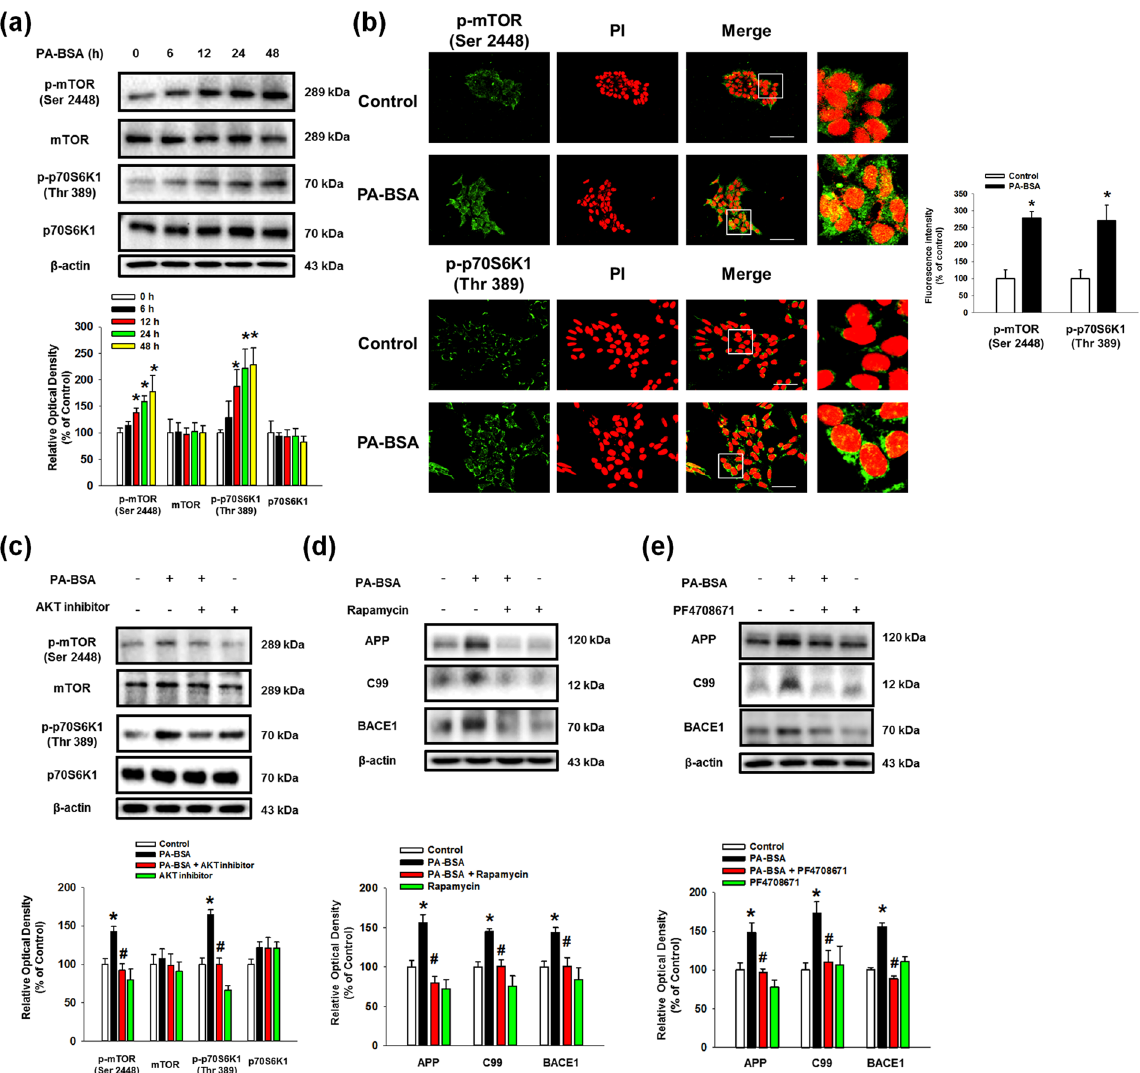
Figure 5. Role of mTOR activated by PA-BSA in APP and BACE1 expressions. ( a ) SK-N-MC cells were incubated with PA-BSA (50 μ M) for 0–48 h. Cells were blotted with p-mTOR (Ser2448), mTOR, p-p70S6K1 (Thr389), p70S6K1 and β -actin antibodies. Data are presented as a mean ± S.E.M. n = 4 . ( b ) SK-N-MC cells were incubated with PA-BSA (50 μ M) for 24 h. Cells were immunostained with p-mTOR (Ser2448) and p-p70S6K1 (Thr389) antibodies and PI. Each fluorescence image is representative. All scale bars, 50 μ m (magnification, × 600). Fluorescence intensity data of p-mTOR (Ser2448) and p-p70S6K1 (Thr389) are reported as a mean ± S.E.M. n = 5 . ( c ) SK-N-MC cells were pre-treated with Akt inhibitor (1 μ M) for 30 min prior to treatment of PA-BSA (50 μ M) for 24 h. The expressions of p-mTOR (Ser2448), mTOR, p-p70S6K1 (Thr389), p70S6K1 and β -actin were analyzed by western blot. Data are reported as a mean ± S.E.M. n = 4 . ( d , e ) SK- N-MC cells were pre-treated with Rapamycin (10 nM) and PF4708671 (10 μ M) for 30 min prior to incubation with PA-BSA (50 μ M) for 24 h. The expressions of APP, C99, BACE1 and β -actin were analyzed by western blot. Data are presented as a mean ± S.E.M. n = 4 . Each blot image is representative. * p < 0.05 versus control, # p < 0.05 versus PA-BSA